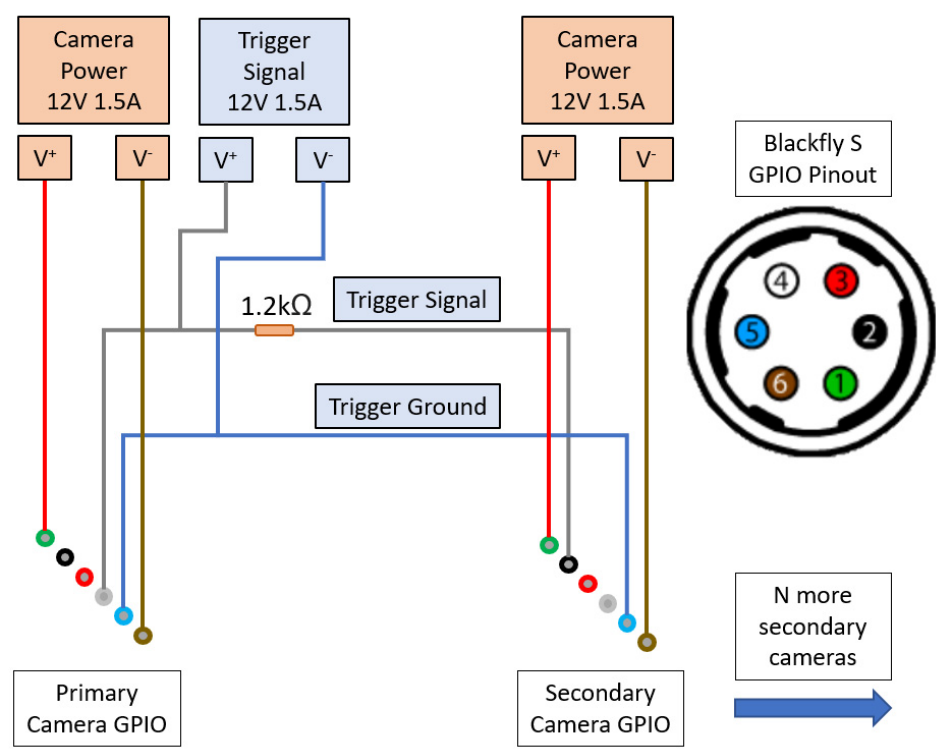
Figure A4. Hardware synchronization cable GPIO pin connections for primary and secondary cam- eras.